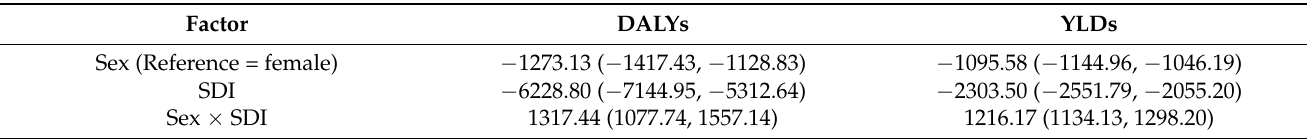
Table 4. Results of the mixed-effects regression on age-standardized DALYs and YLDs rates attributed to nutritional deficiency on sex, SDI, and sex by SDI, among older adults from 1990 to 2019 in the Western Pacific region. Factor DALYs YLDs Sex (Reference = female) − 1273.13 ( − 1417.43, − 1128.83) − 1095.58 ( − 1144.96, − 1046.19) SDI − 6228.80 ( − 7144.95, − 5312.64) − 2303.50 ( − 2551.79, − 2055.20) Sex × SDI 1317.44 (1077.74, 1557.14) 1216.17 (1134.13, 1298.20) Models have controlled for time and country. Data are shown as coefficients (95% confidence interval). Abbreviations: DALYs, disability- adjusted life years; YLDs, years lived with disability; SDI, social development